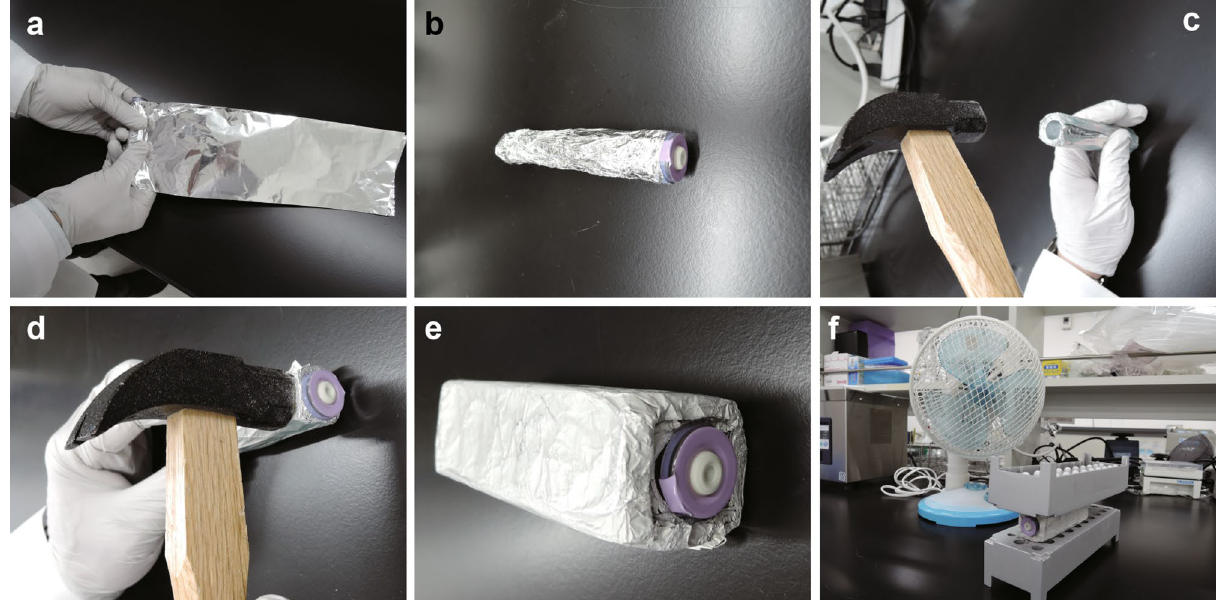
Figure 5. Procedure for thawing frozen whole blood samples stored in ethylenediaminetetraacetic acid (EDTA) tubes. ( a ) Wrap aluminum foil tightly around the EDTA tube. ( b ) Repeat the wrapping process until the aluminum foil does not lose its shape when the EDTA tube is pulled out. ( c ) Beat the top and bottom of the aluminum with a hammer. ( d ) Beat the side of the aluminum with a hammer. ( e ) Repeat steps ( a–d ) until the thickness of the aluminum block is around 1 cm. ( f ) Place the EDTA tube containing the frozen whole blood sample in an aluminum block, sandwich it between aluminum racks for microtubes, and blow it with a fan. The images were created using Adobe Illustrator CS5 (https:// www. adobe.